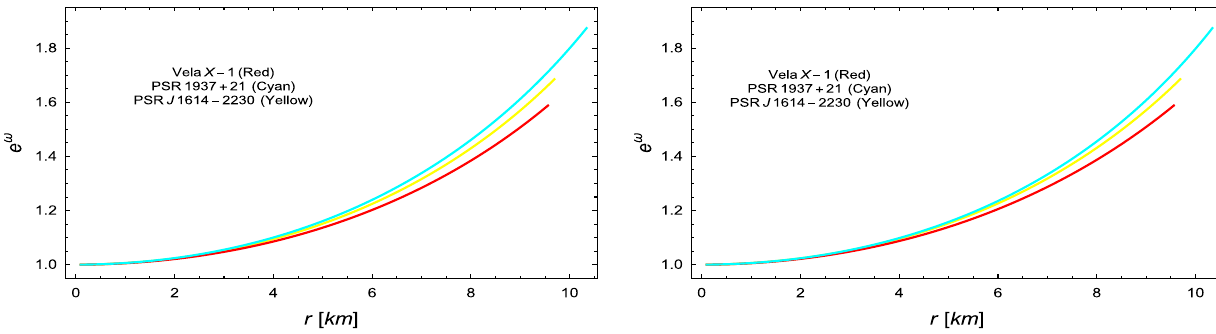
Fig. 2 Shows the variations of radial metric potential e ω (left panel for 1st solution and right panel for 2nd solution) with respect to r + 55 C 3 r 4 ( 16 r 4 ( 693 a + 2